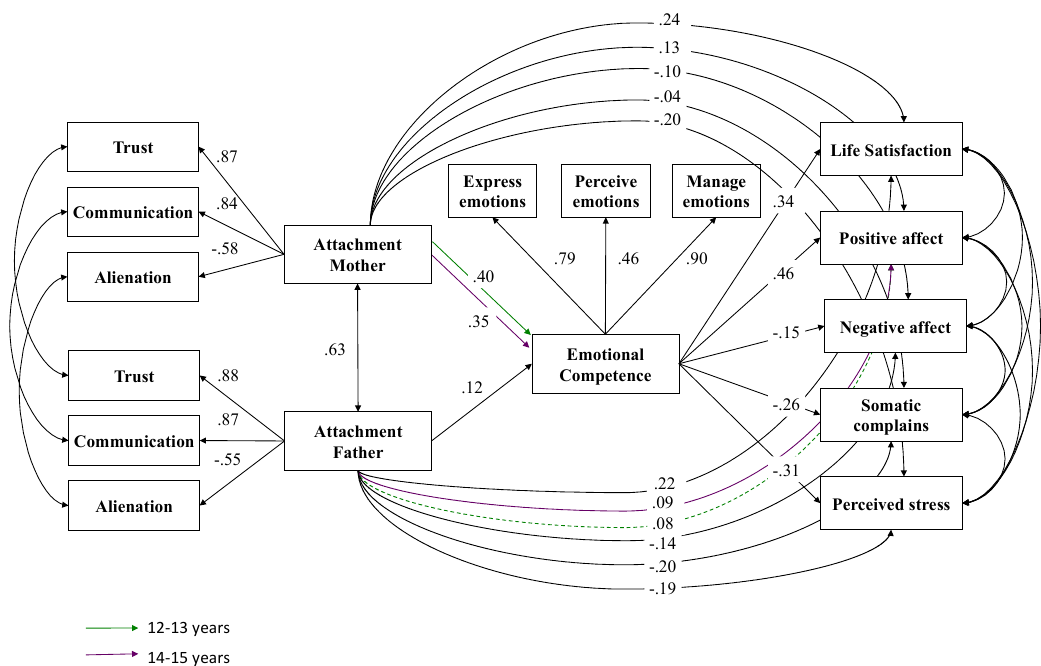
Figure 3. Multi-group path model: Age differences. Note: Significant effects shown as standardized coefficients (β); bold pathways are significant at p < 0.01; dotted pathways are not significant; factor loadings are standardized.